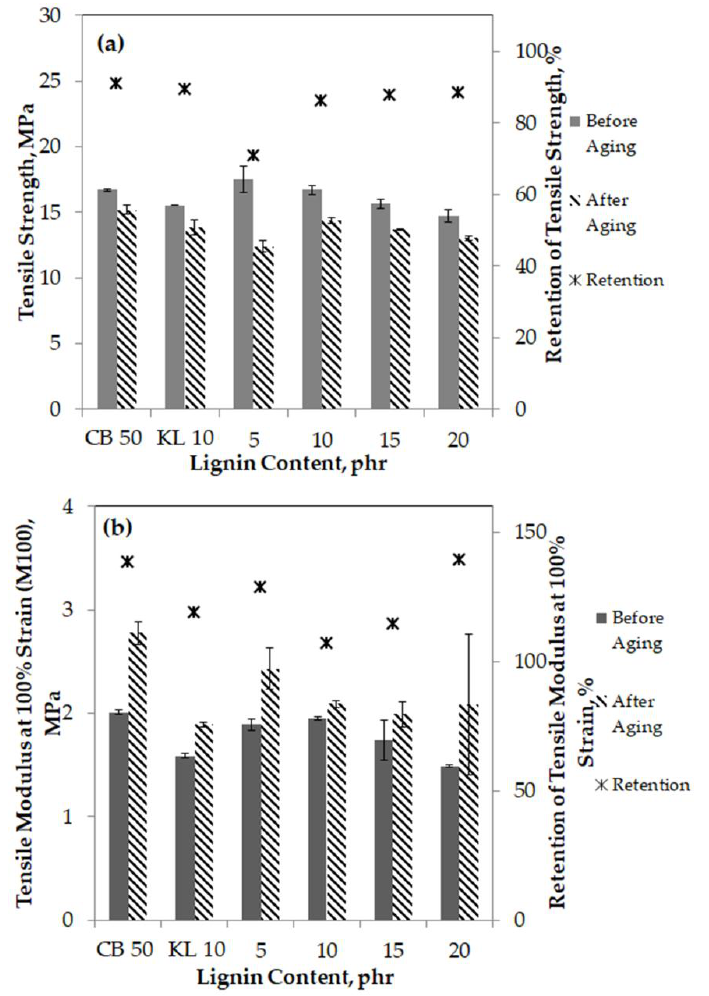
Figure 14. The effect of HMKL content on the retention of ( a ) tensile strength and ( b ) tensile modulus at 100% strain in lignin-filled NR/BR compounds.